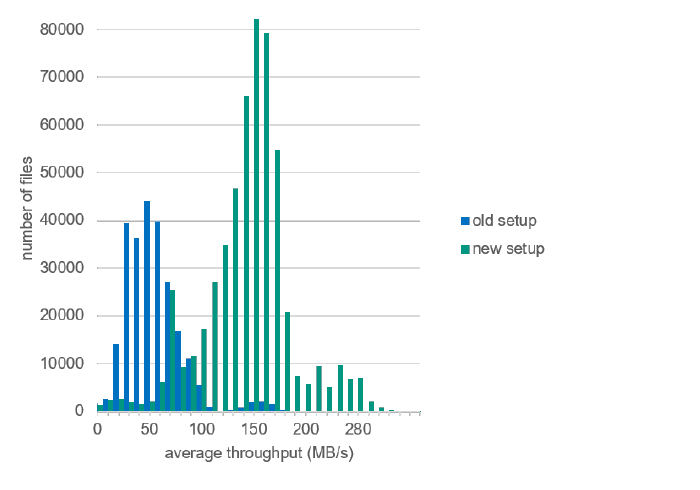
Figure 2: Histogram of Recall Rates per